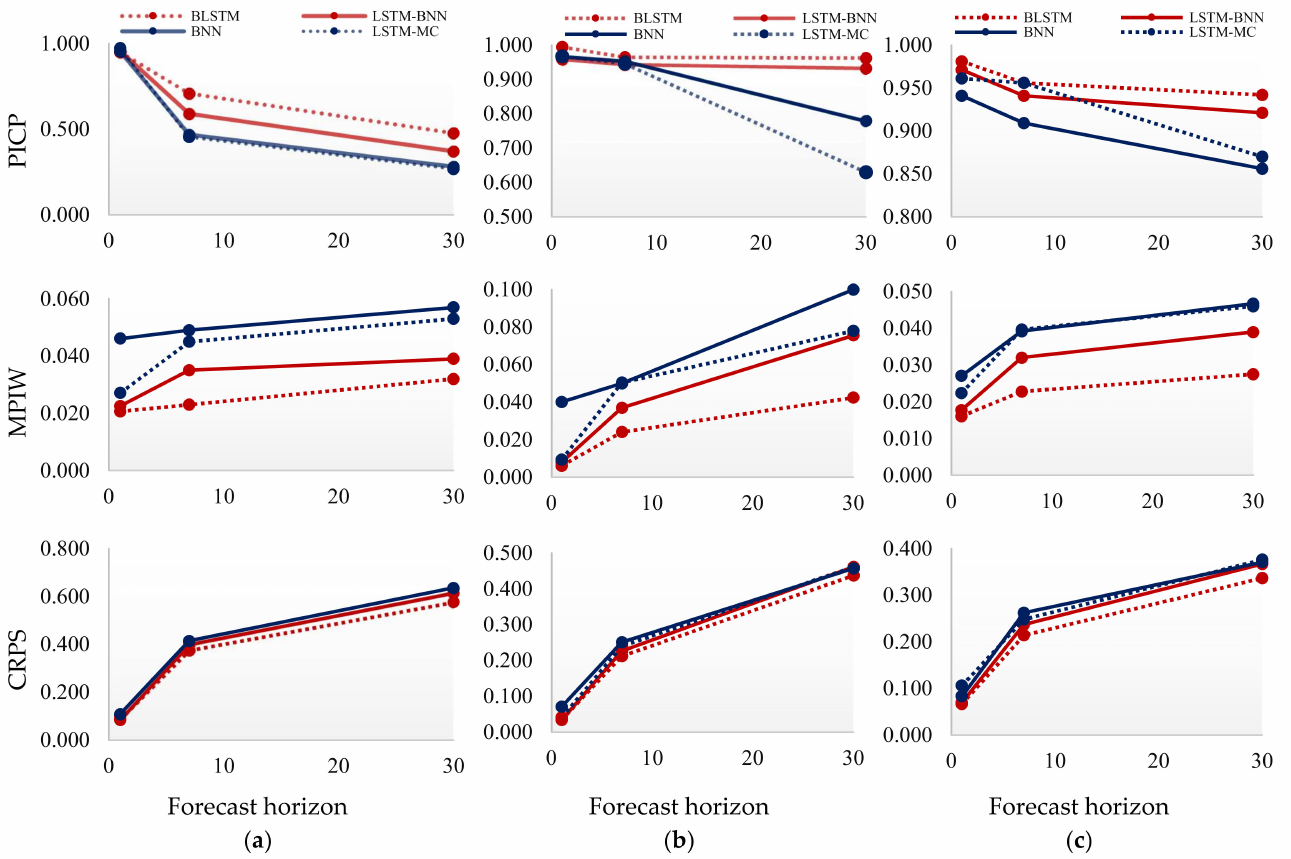
Figure 11. Change in probabilistic streamflow forecasting results by increasing horizon for ( a ) case study I, ( b ) case study II, and ( c ) case study